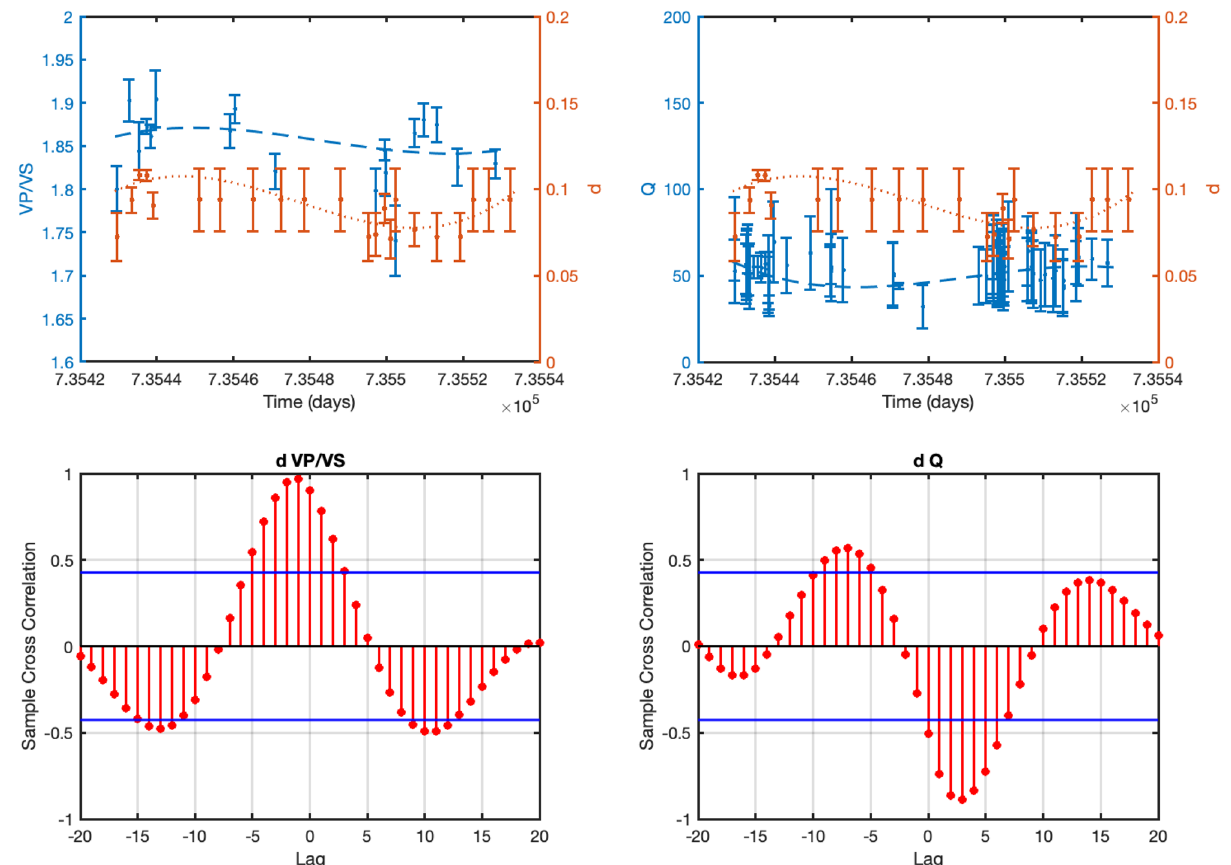
Figure 8. Same as Fig. 6 but for St. Gallen geothermal field (time-lag = 5